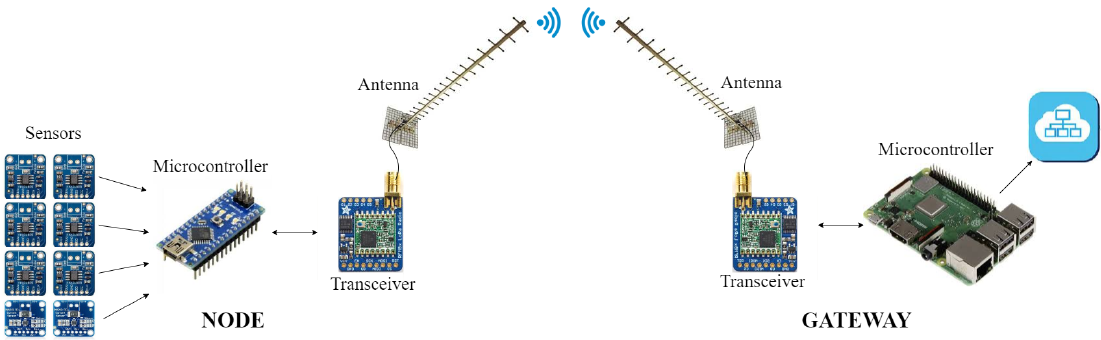
Figure 7. Schematics of a communication system implemented with